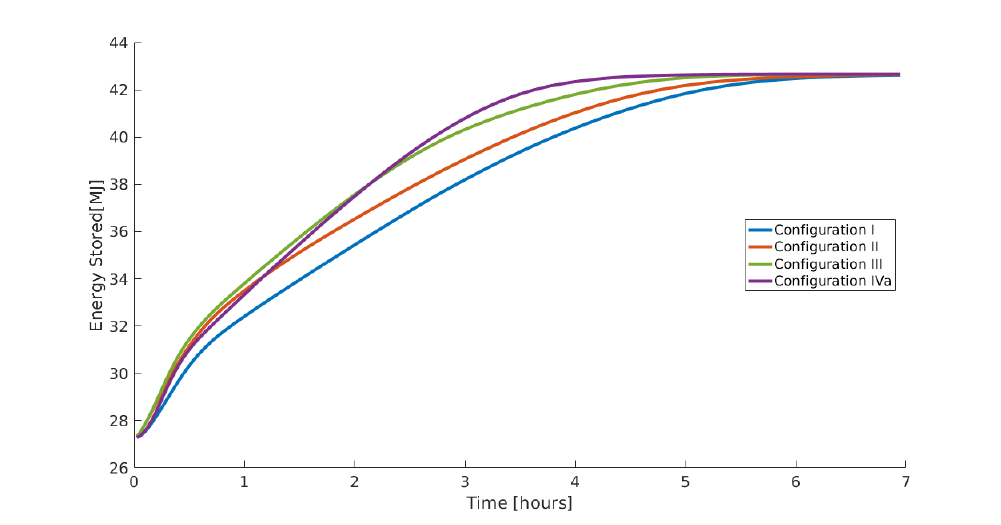
Figure 7. Energy stored inside PCM for different configurations during the heating